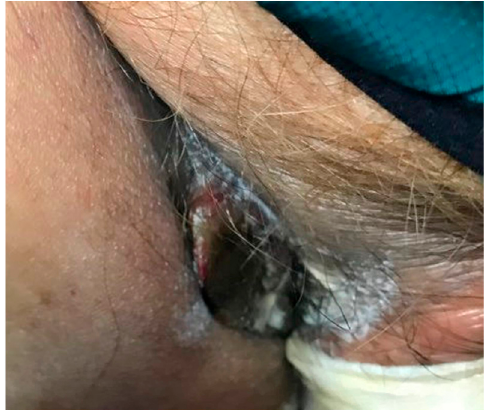
Figure 3. At follow up, the nodule had decreased in size and induration with interval improvement of the erythema, ulceration, and crust.